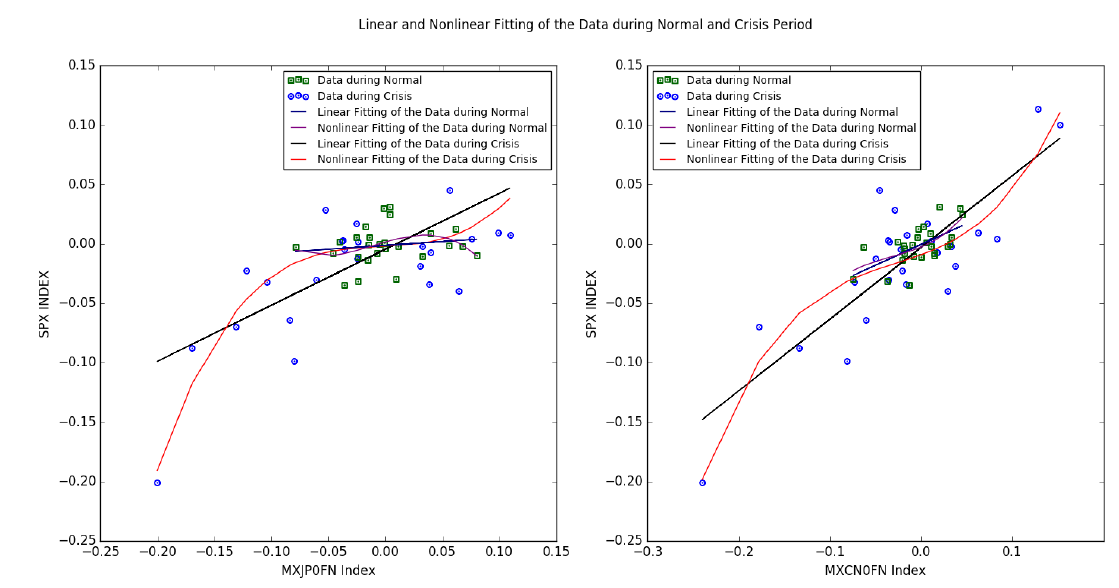
Figure 9. Linear and Nonlinear